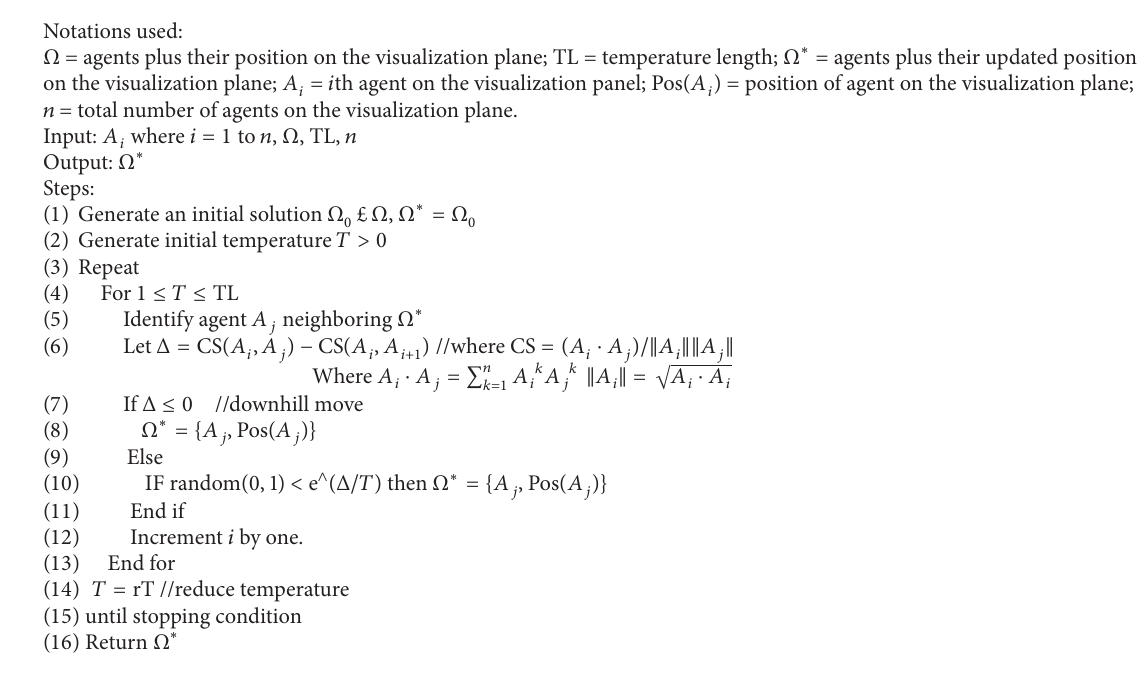
Algorithm 2: Cooling